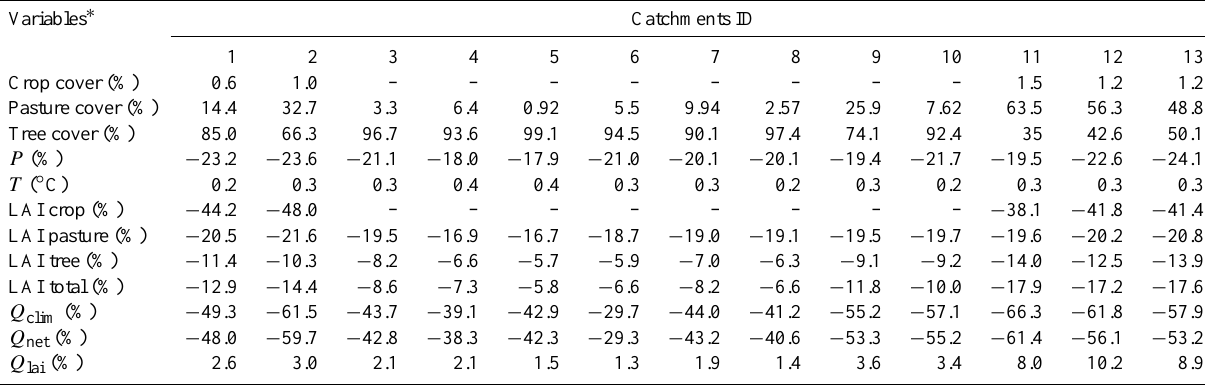
Table 2. Vegetation type distributions for each sub-catchment and changes in mean annual precipitation, temperature, LAI and streamflow during the Millennium Drought of 1997–2009 relative to